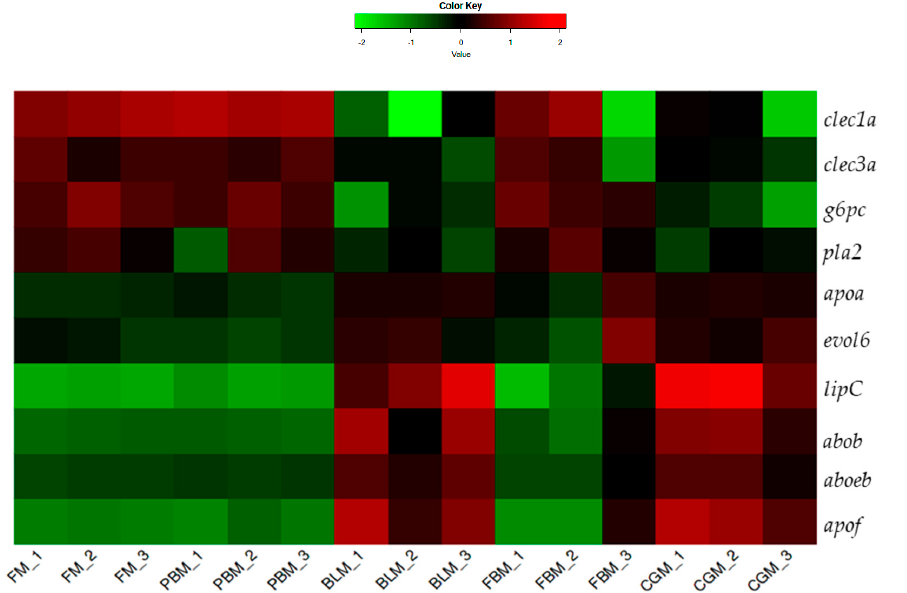
Figure 4. Expression levels of genes related to lipid and carbohydrates metabolism in fish fed different